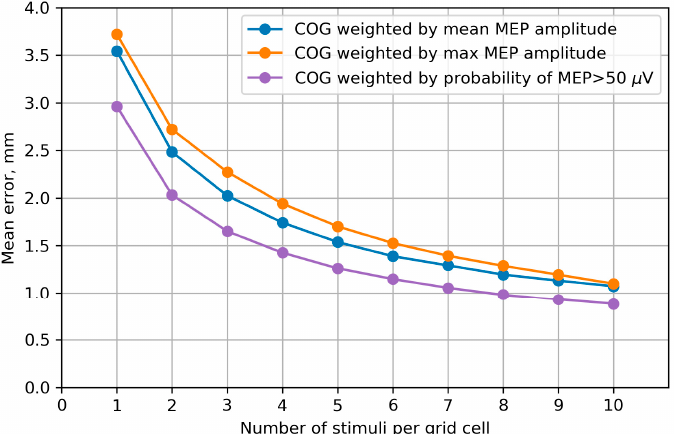
Figure 8. Accuracy of the center of gravity (COG) estimates computed using three alternative methods of assigning weights to the stimulation points. The accuracy is measured by the mean distance between the COG calculated from the full map and the COGs of 1000 maps generated by bootstrapping. The median values from all maps of all subjects are shown. The di ff erences in the COG accuracy between the three methods are statistically significant for all numbers of stimuli smaller than 8 ( p < 0.05, Friedman test). The highest accuracy is achieved by the approach in which the stimulus location vectors are weighted by the probability of a suprathreshold MEP in them (purple curve), although the accuracy di ff erences between the methods are small (less than 1 mm). For all the COG variants, the error significantly decreases with the number of stimuli per cell ( p < 0.001, Page’s trend test).